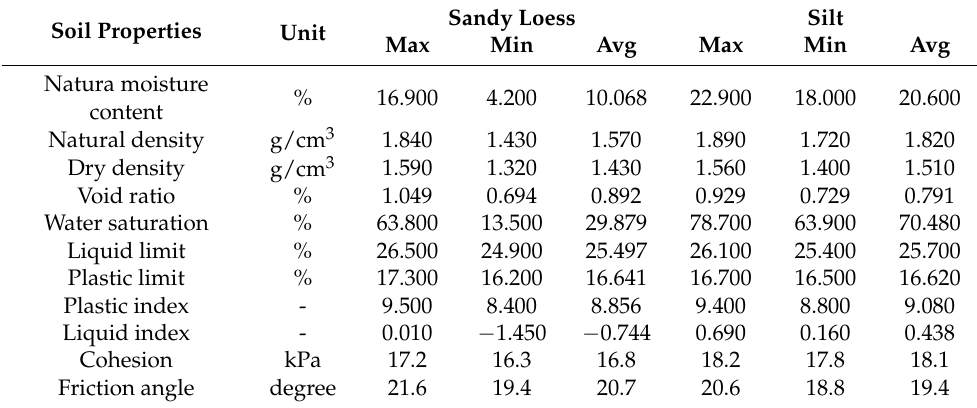
Figure 2. Geological conditions of the site based on drilling-hole tests. Table 1. Basic properties of the sandy loess and silts.